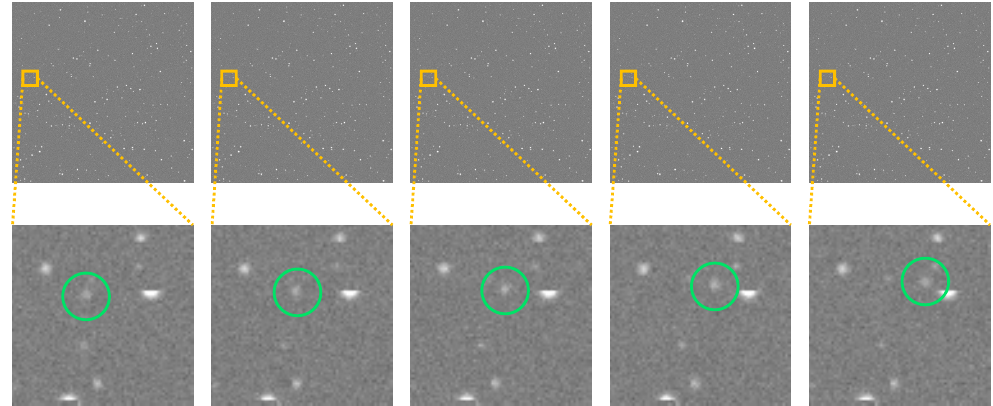
Figure 7. Example of a video sequence with SNR = 0.2, diameter = 0.1 m, speed = 4 pixel/frame, direction = 10 ◦ in SDD dataset (top row). Close-up of space debris marked by a green circle in the image sequence (bottom